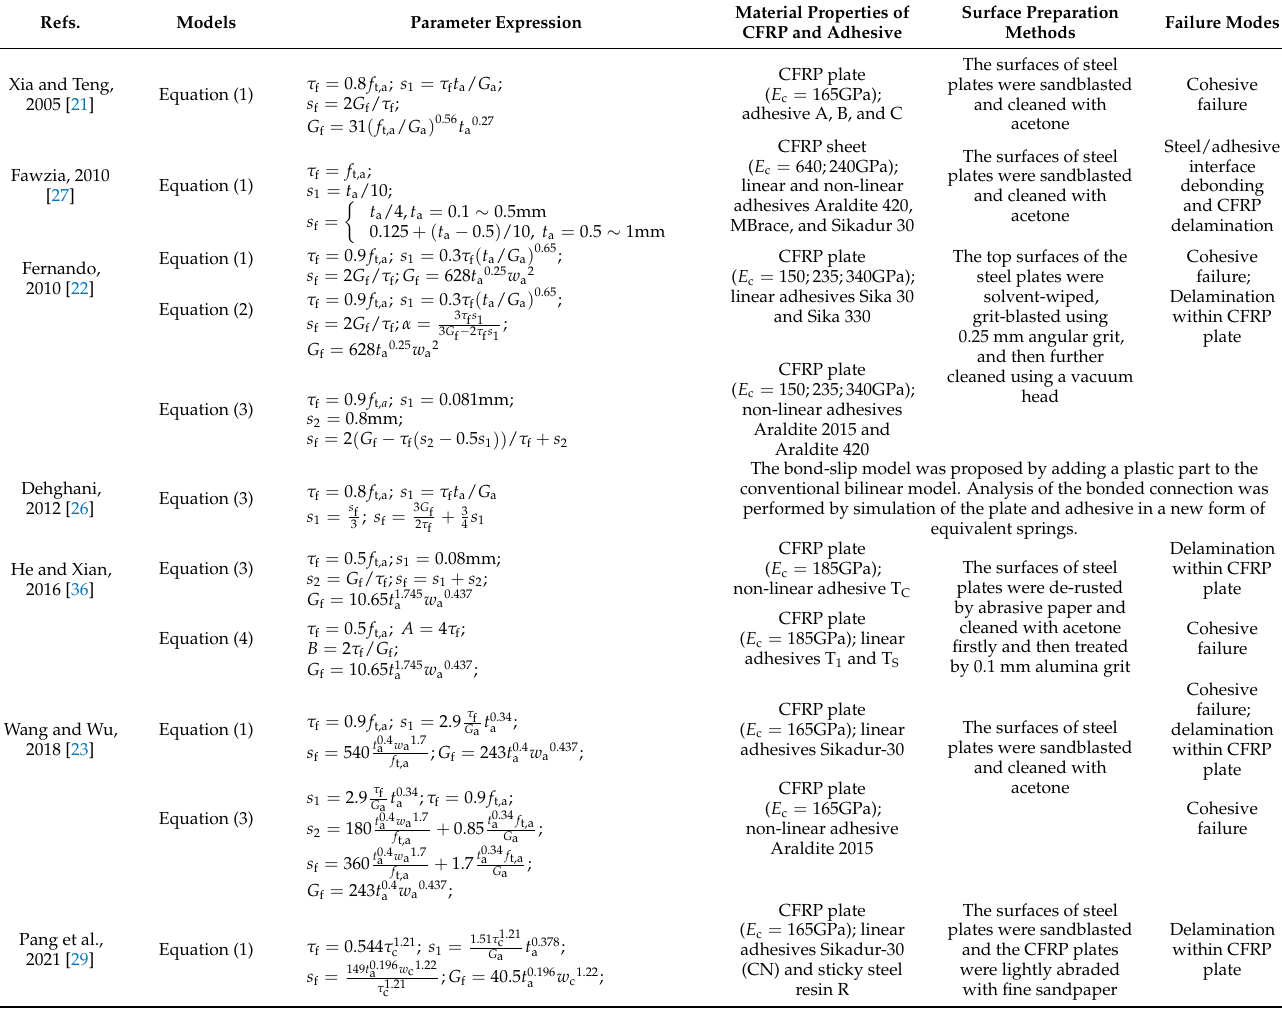
Table 1. Summary of bond-slip models for CFRP materials bonded to uncorroded steel plate.